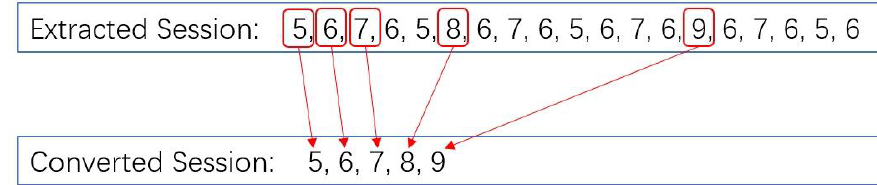
Figure 5. The proposed session refining method.